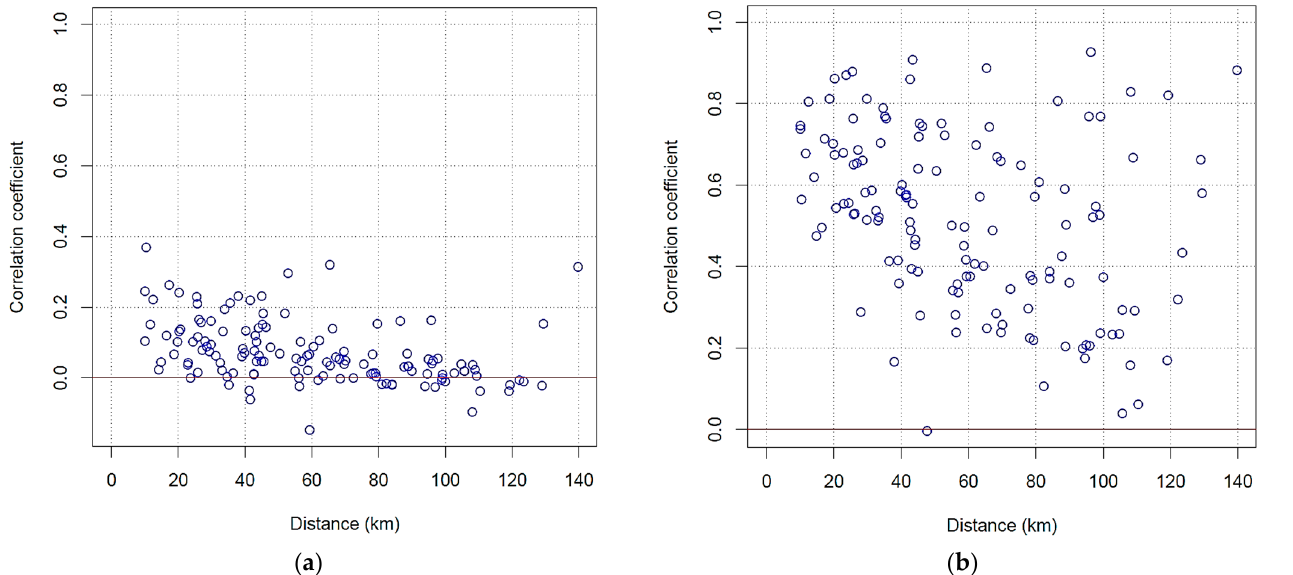
Figure 5. Correlogram between stations: ( a ) Daily precipitation series and ( b ) Monthly precipitation series.